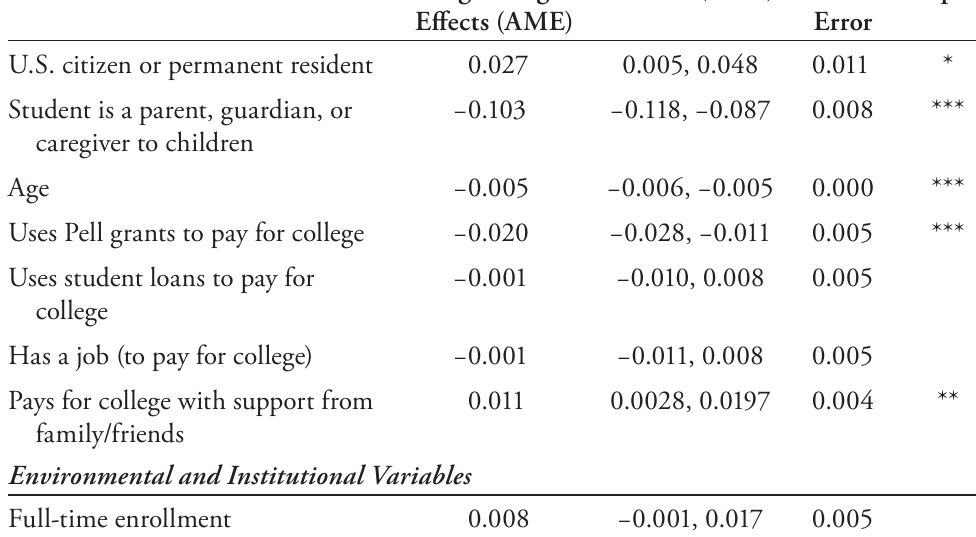
Table 2. Results of the Logistic Regression for Major Depressive Disorder (MDD) ( continued